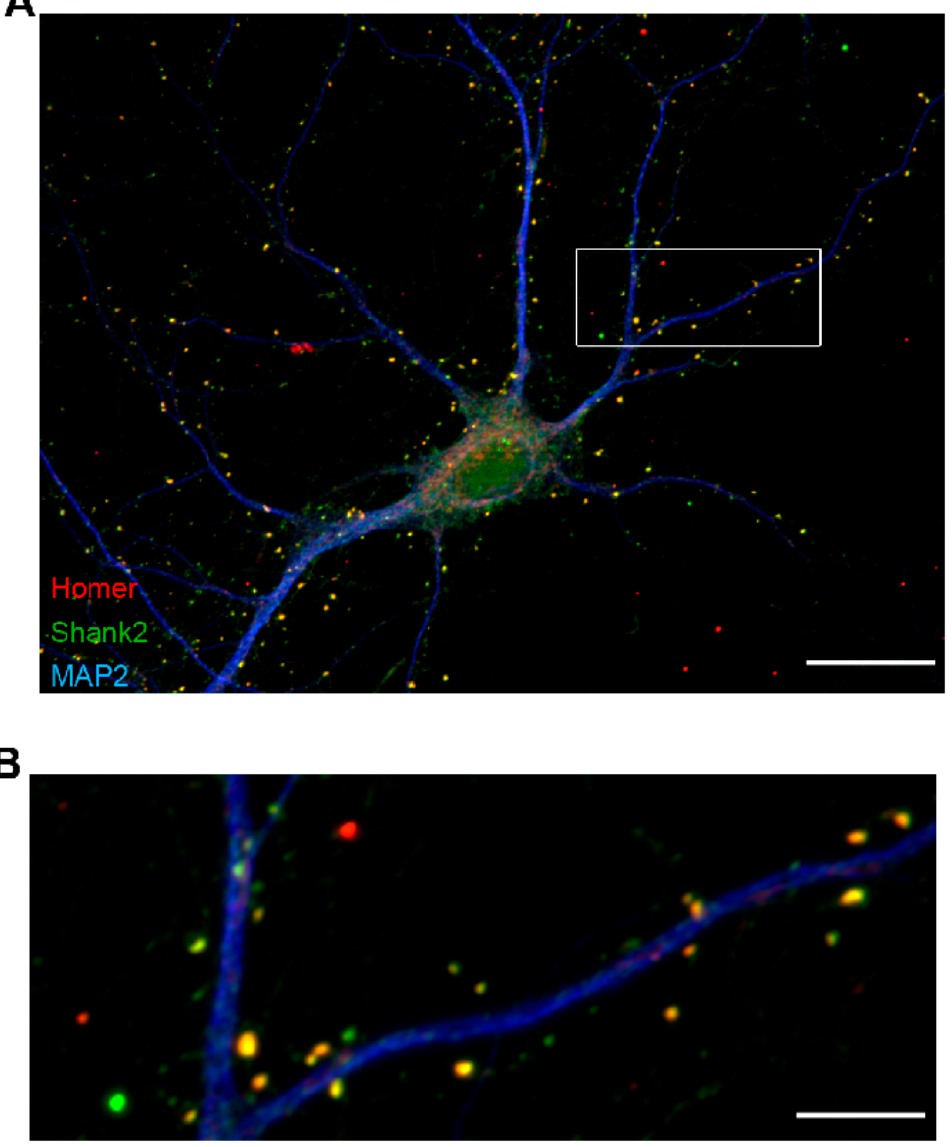
Figure 1. Single cell layer representation of postsynaptic proteins Homer and Shank2/ProSAP1. ( A ) Immunostaining of cultured rat hippocampal neurons (DIV16) recorded with a 63×/1.4 objective on a Zeiss AxioObserver.Z1 equipped with an ApoTome.2 confirms colocalization of the postsynaptic density proteins Homer 1 (Homer; red) and postsynaptic density protein Shank2/ProSAP1 (Shank2; green) at structures protruding from dendrites marked by microtubule-associated protein 2 (MAP2; blue). ( B ) Enlarged view of the boxed region depicted in A. Scale bar, 20 µm in ( A ), 5 µm in ( B ).